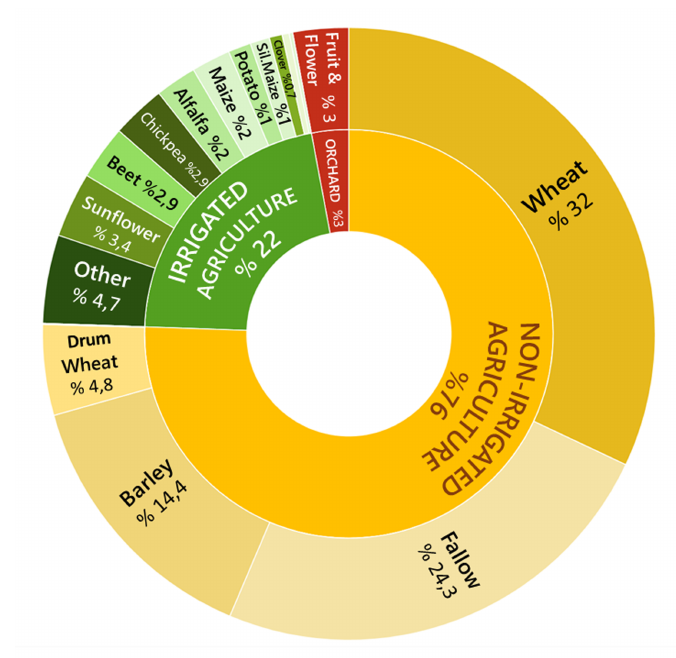
Figure 5. Agricultural land and crop pattern distribution in 2015 for the Sakarya River